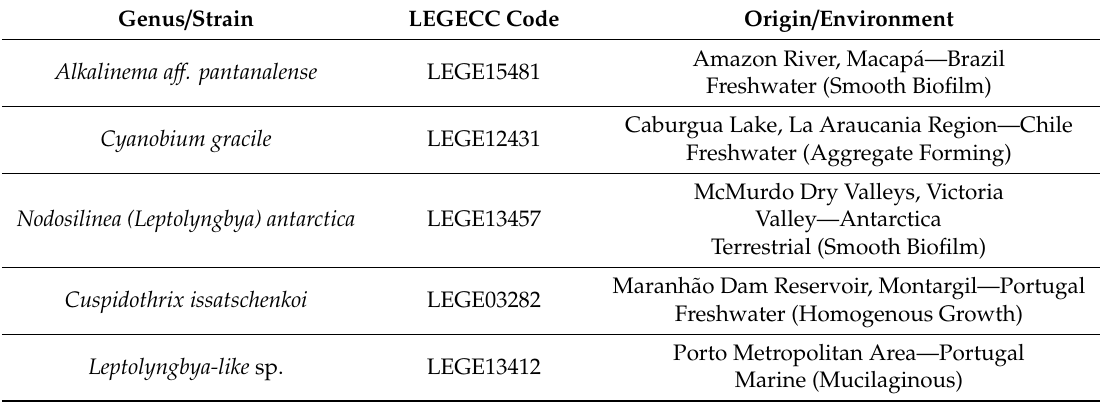
Table 1. Origin and morphological features of the cyanobacteria strains used in the study 1 . Genus / Strain LEGECC Code Origin / Environment Alkalinema a ff . pantanalense